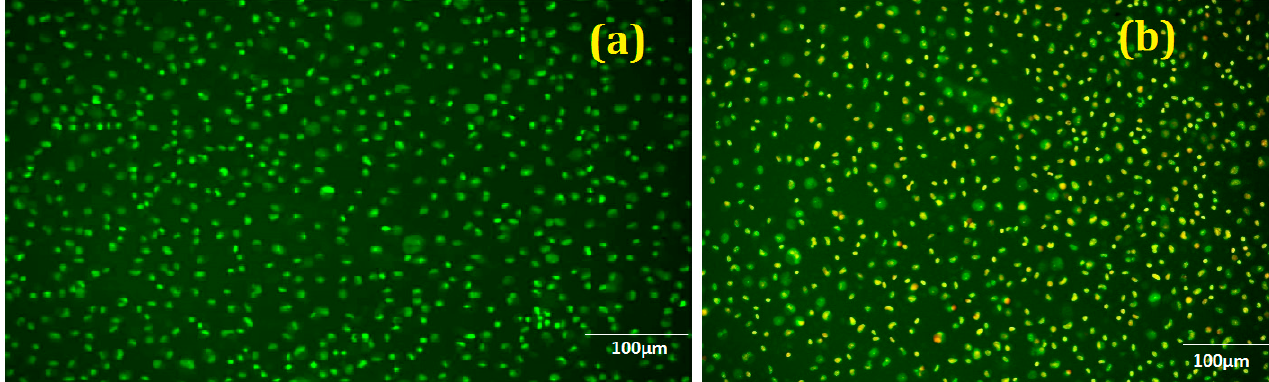
Figure 9. Cell growth and proliferation ( a ) controlled ( b ) treated with ZCC.